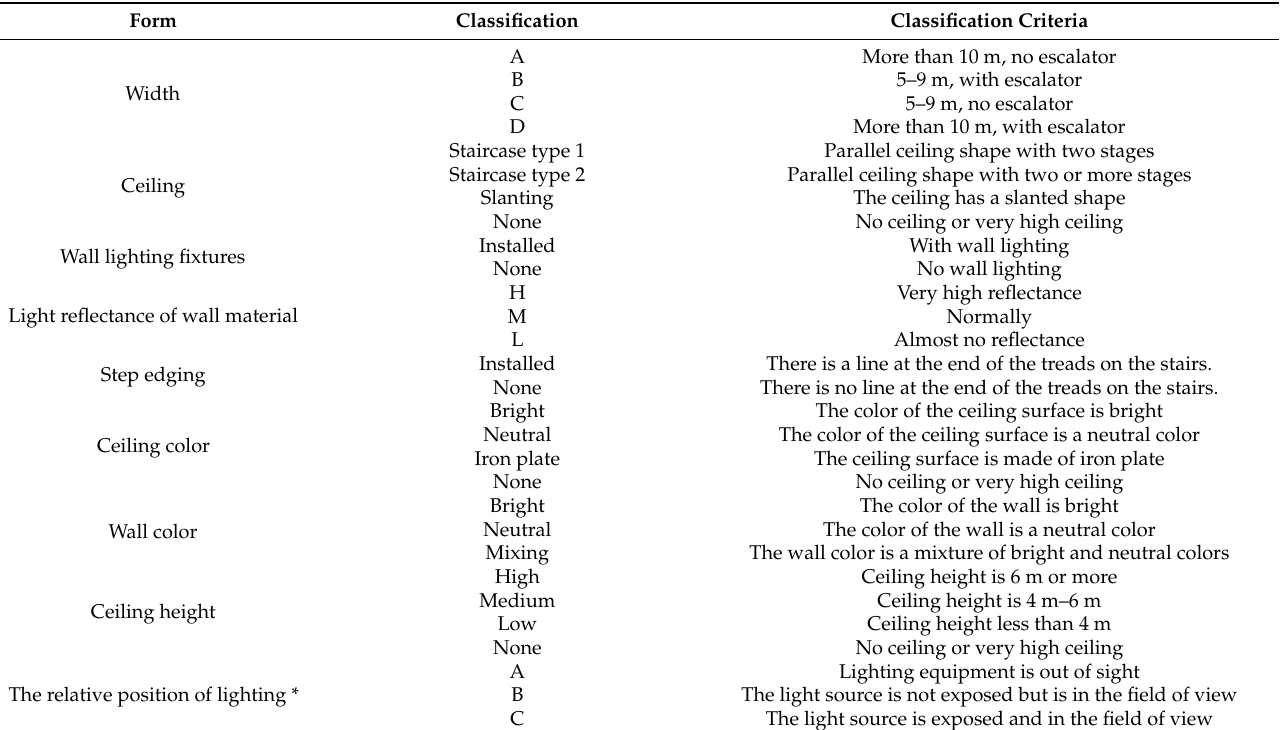
Table 1. Form classification criteria table of the stair.